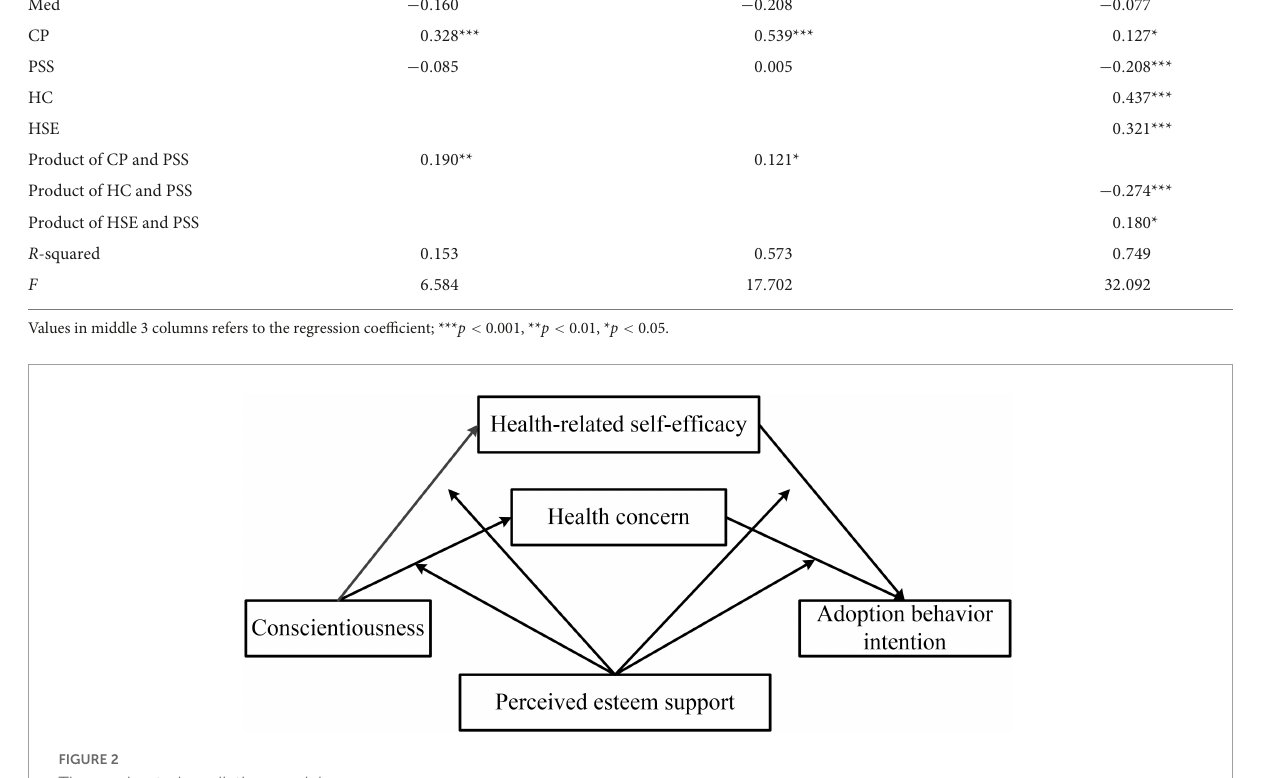
FIGURE2 The moderated mediation